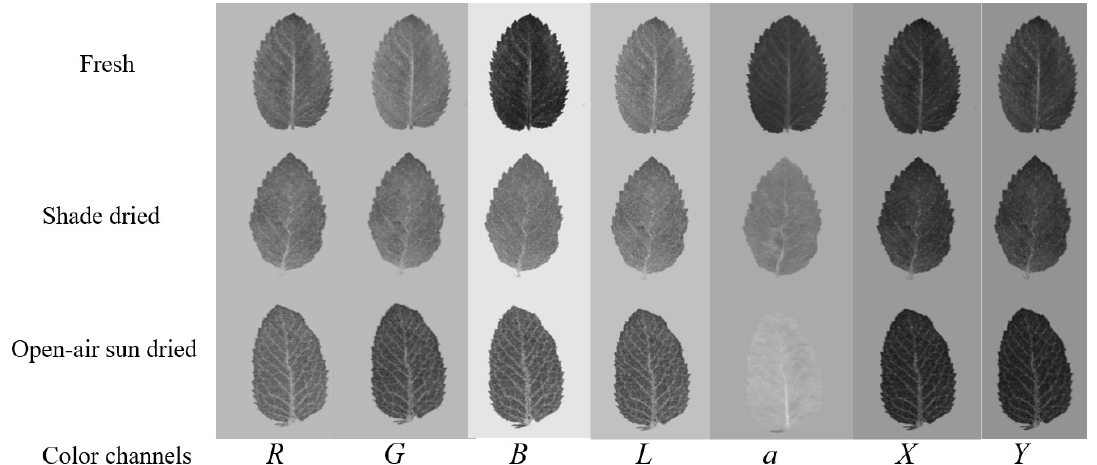
Figure 4. The images of the dorsal side (lower surface) of fresh and dried mint leaves in different color channels R , G , B , L , a , X , and Y .